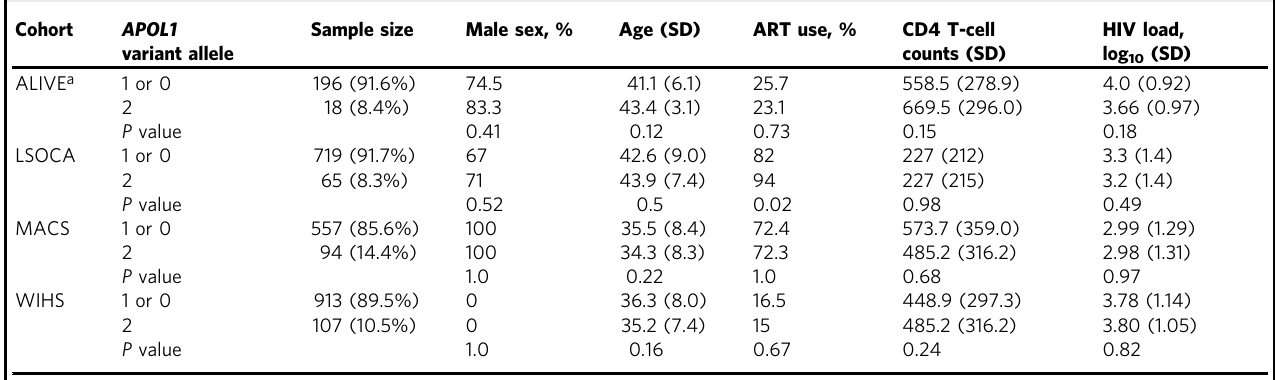
Table 1 Baseline characteristics of seroprevalent participants with HIV infection at study entry by APOL1 variant allele counts in the ALIVE, WIHS, MACS, and LSOCA cohorts.